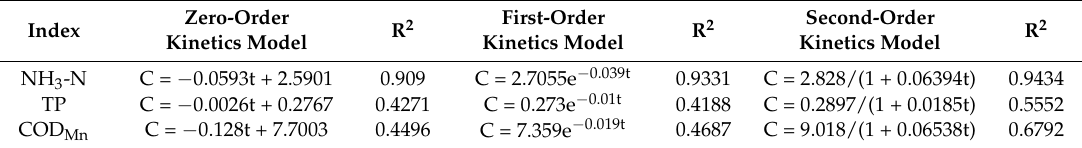
Table 8. Fitting results of biodegradation kinetic model, C: concentration of NH 3 -N, TP and COD Mn (mg/L).